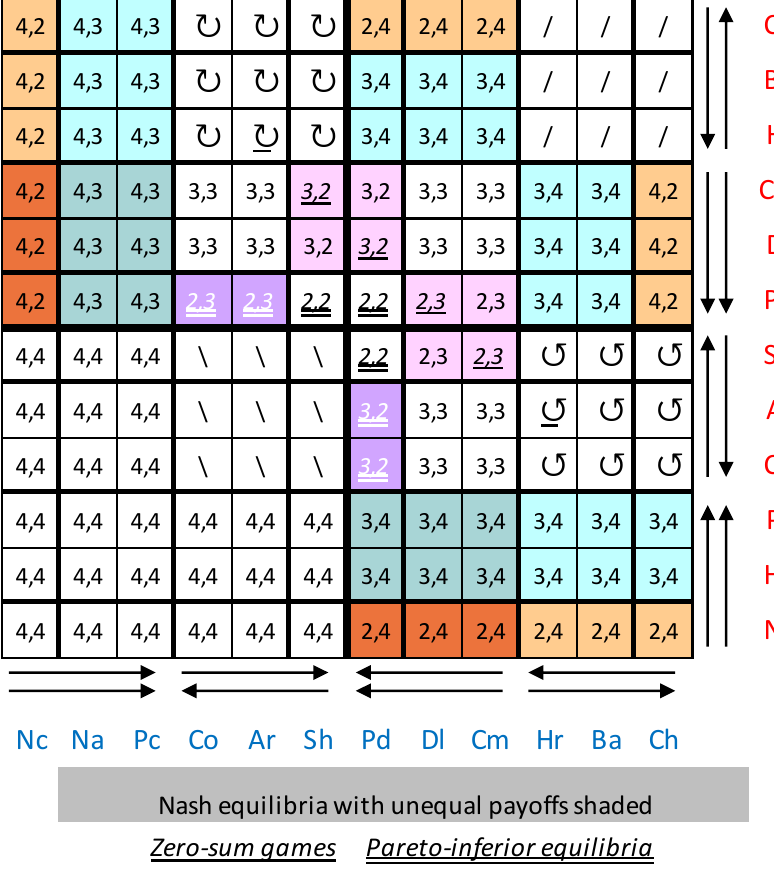
Figure A9. Bias games. Dominant strategies lead to unequal payoffs at equilibrium.